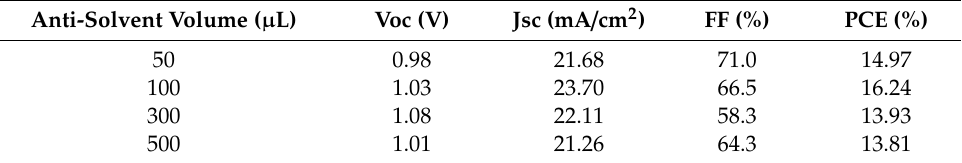
Table 2. Photovoltaic parameters of device by using di ff erent quantity of anti-solvent EA. Anti-Solvent Volume ( µ L)